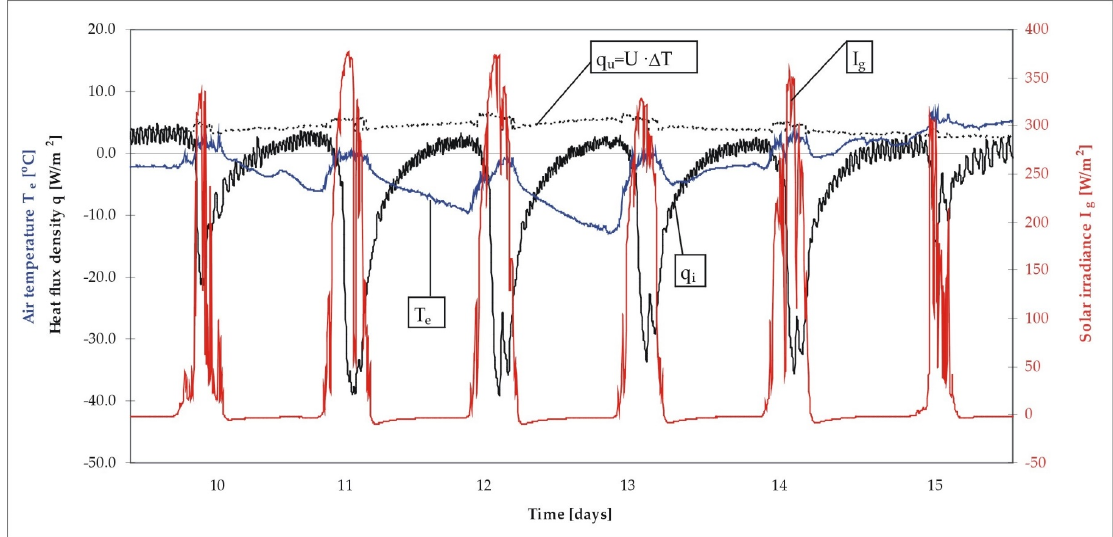
Figure 9. Distribution of air temperature outside the chamber Te, heat flux density measured on the IGW inner surface and solar irradiation measured behind the glazing in the period of considerable solar